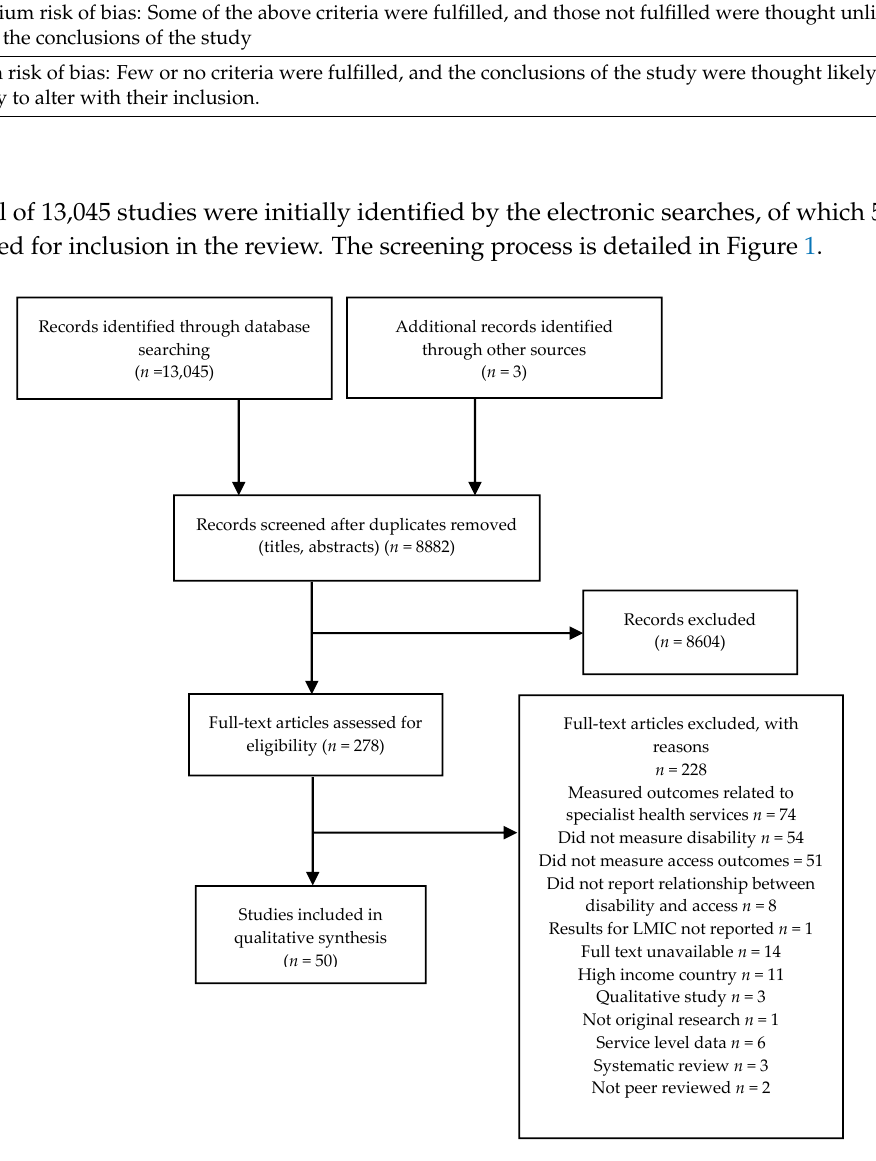
Figure 1. Flow chart of search results.